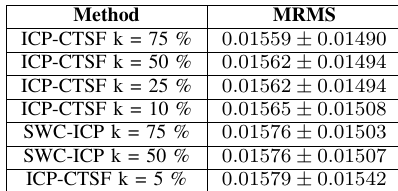
TABLE XIV: Best seven methods for video ‘freiburg2 xyz’ according to the MRMS given by expression